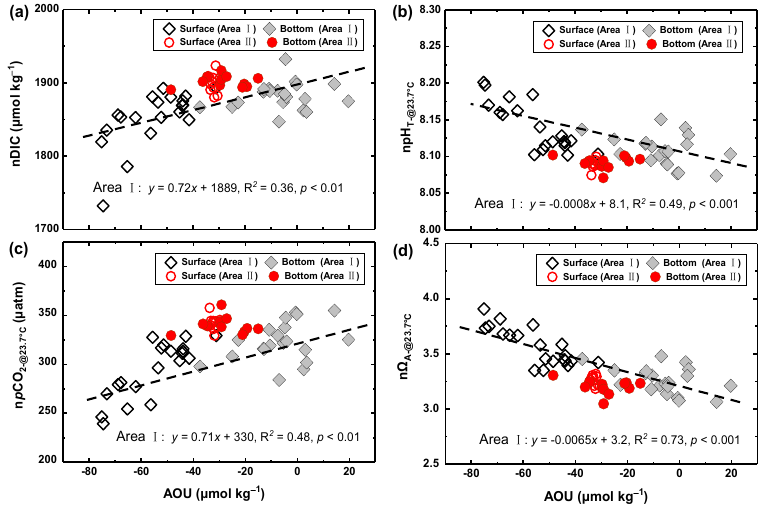
Figure 6. The correlation of inorganic carbon parameters with AOU ( a – d ) in the surface and bottom water of Yangmeikeng Sea Area (Area I) and Dalu Bay (Area Ⅱ ).